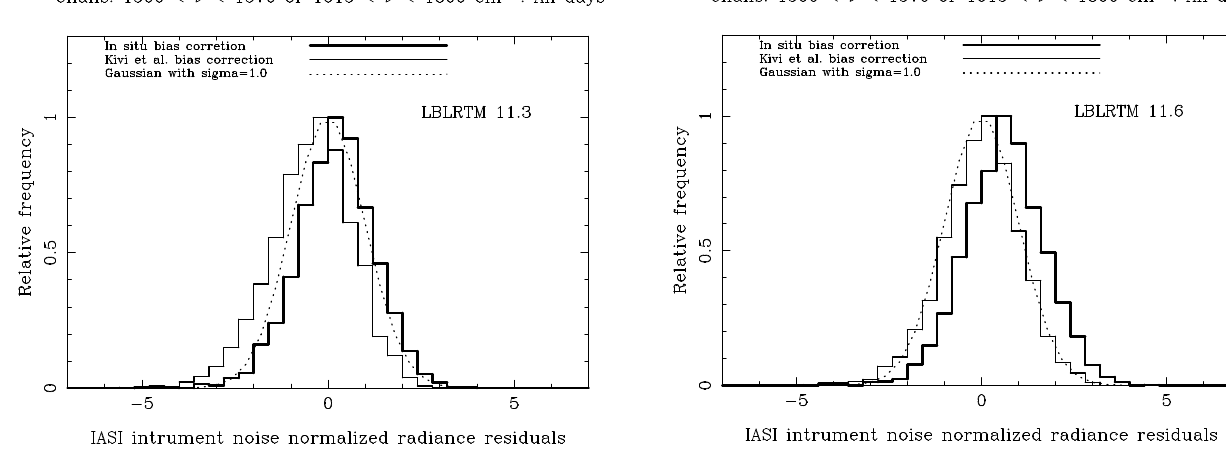
Fig. 10. Histogram of the residual radiances, IASI observed mi- nus calculated with LBLRTM 11.3 RTM and time interpolated pro- files, for all clear days (4) in the spectral range, 1500cm − 1 ≤ ν ≤ 1570cm − 1 and 1615cm − 1 ≤ ν ≤ 1800cm − 1 . One set of interpo- lated profiles have been derived from the CFH sonde launched 1h before IASI overpass and the “in situ” bias corrected RS92 sonde launched 5min before satellite overpass (thick solid line). The other set of interpolated profiles have been derived from the CFH sonde launched 1h before IASI overpass and the Kivi et al. bias cor- rected RS92 sonde launched 5min before satellite overpass (thin solid line). For reference, a Gaussian curve with a σ of 1.0 is shown (dotted line).